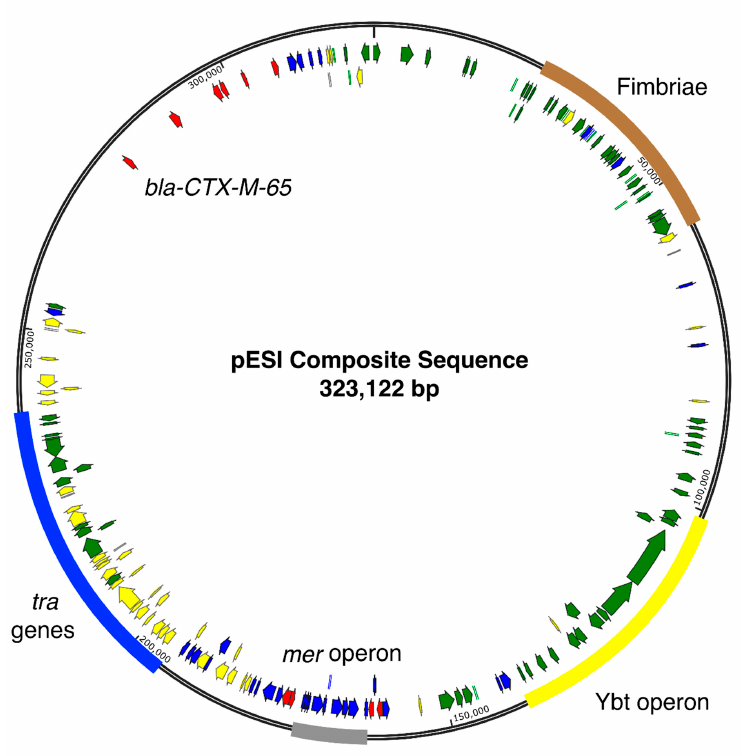
Figure 2. Composite sequence of the pESI plasmid. Genes detected in more than 90% of isolates arranged according to CP016407.1. Each arrow represents a gene present in at least 90% of isolates or an antibiotic resistance gene. Green arrows indicate genes detected in more than 99% of isolates. Yellow arrows represent genes detected in greater that 95% of isolates. Blue arrows represent genes detected in more than 90% of isolates. Antibiotic resistance genes are represented by red arrows, regardless of detection frequency. Regions of important genes are labeled.